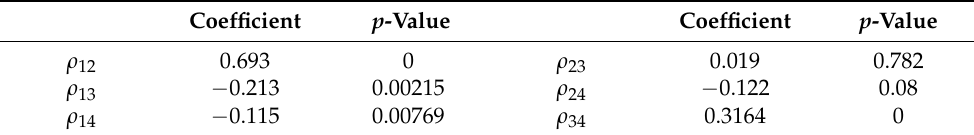
Table A1. Pearson correlation coefficient and the corresponding p -values. Coefficient p